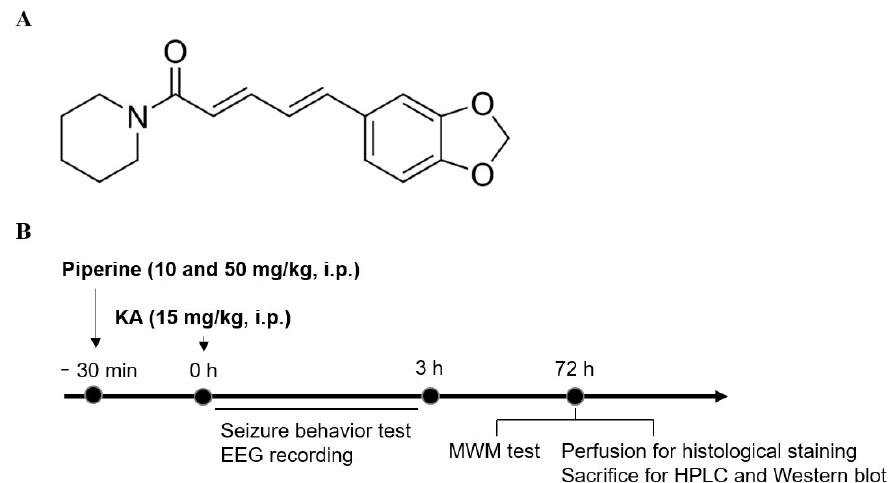
Figure 1. ( A ) Chemical structure of piperine. ( B ) Experimental design. Rats were administered piperine (10 and 50 mg/kg, i.p.) 30 min before KA injection (15 mg/kg, i.p.). Seizure behaviour and epileptic bursts were recorded 3 h after KA administration. At 3 days after KA injection, the rats were examined by the Morris water maze (MWM) test and sacrificed for high-performance liquid chromatography (HPLC), Western blot, and immunohistochemistry (IHC) studies.